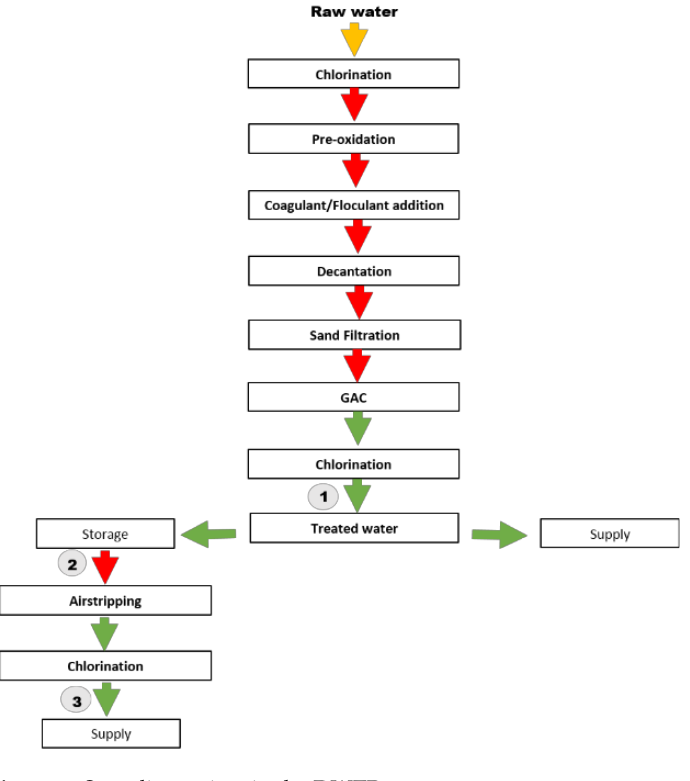
Figure 1. Sampling points in the DWTP.